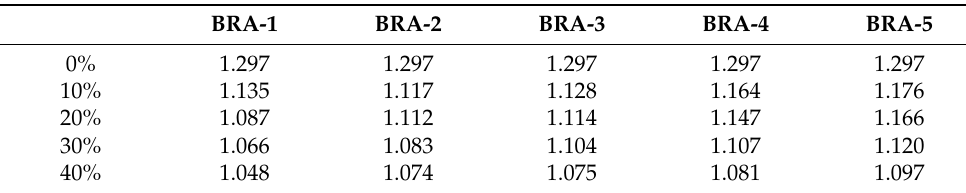
Figure 14. Viscosity–temperature curve of BRA-MA with BRA-1 for VTS. Table 3. Absolute value of BRA-MA VTS values.